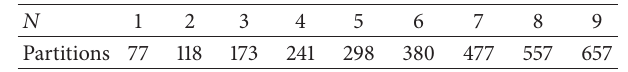
Figure 5: The control input 𝑢 ( 𝑁 = 9 ).